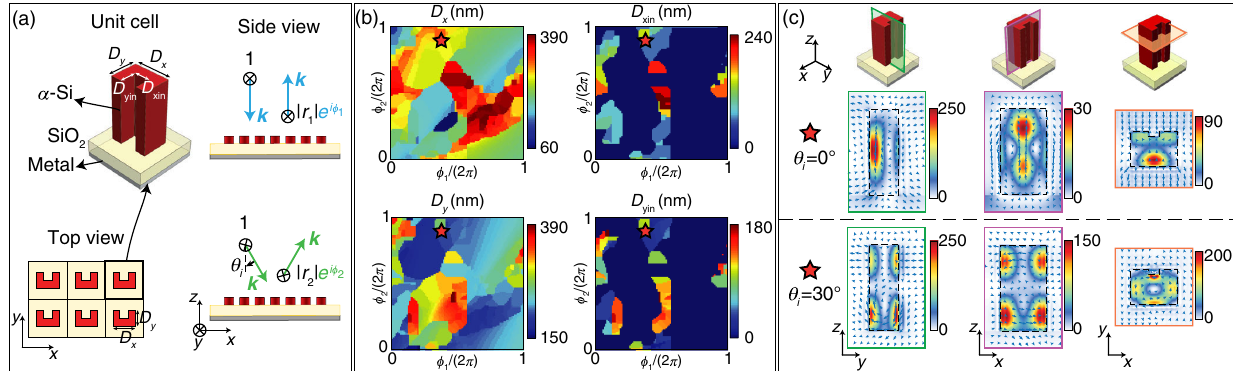
FIG. 2. The meta-atom structure and the design graphs. (a) Schematic drawing of various views of a uniform array of U-shaped cross- section α -Si meta-atoms arranged in a square lattice resting on a thin SiO 2 spacer layer on a reflective surface (i.e., a metallic mirror). The array provides angle-dependent response such that TE-polarized light at 0° and 30° illumination angles undergoes different phase shifts as it reflects from the array. (b) Simulated values of the U meta-atom dimensions ( D phase shifts for TE-polarized light at 0° and 30° illumination angles, respectively. From (b), one can find the dimensions of a meta-atom that imposes ϕ 1 and ϕ 2 phase shifts under 0° and 30° illuminations, respectively. (c) Electric energy density inside a single unit cell in a periodic uniform lattice for a typical meta-atom [shown in (b) with a star symbol] at 0° and 30° illumination angles, plotted in three cross sections. Blue arrows indicate in-plane electric field distributions excited at each illumination angle. Different field distributions at normal and 30° incidence are an indication of excitation of different resonant modes under different incident angles. In all parts of the figure, the meta-atoms are 500 nm tall. The silicon dioxide and aluminum layers are 125 nm and 100 nm thick, respectively, the lattice constant is 450 nm, and all simulations are performed at a wavelength of 915 nm. ( α -Si: amorphous silicon, SiO 2 : silicon